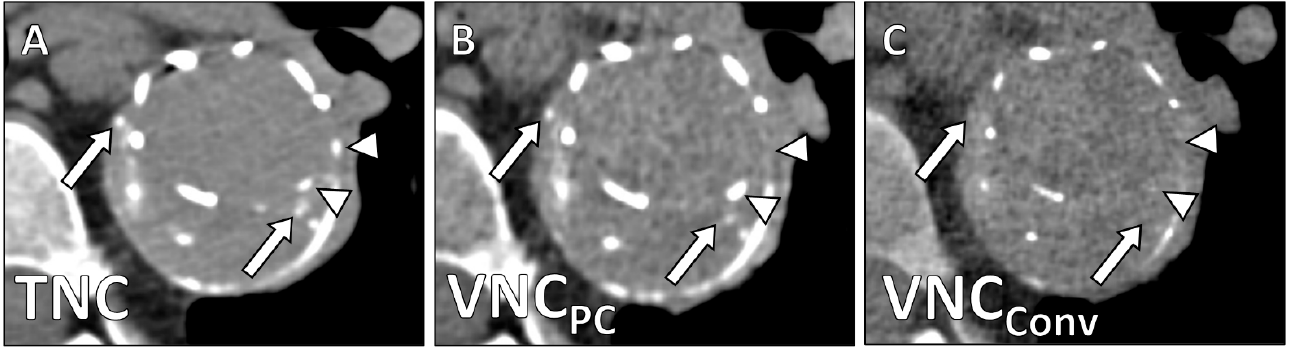
Figure 3. Stent after EVAR in the thoracic aorta with peripheral and central calcifications in the aneurysm sac. ( A ) TNC-series, ( B ) VNC PC -series, and ( C ) VNC Conv -series. White arrows point to calcifications that show lesser density in VNC PC - and full subtraction in VNC Conv -reconstructions. White arrowheads show missing stent struts in VNC Conv -series.